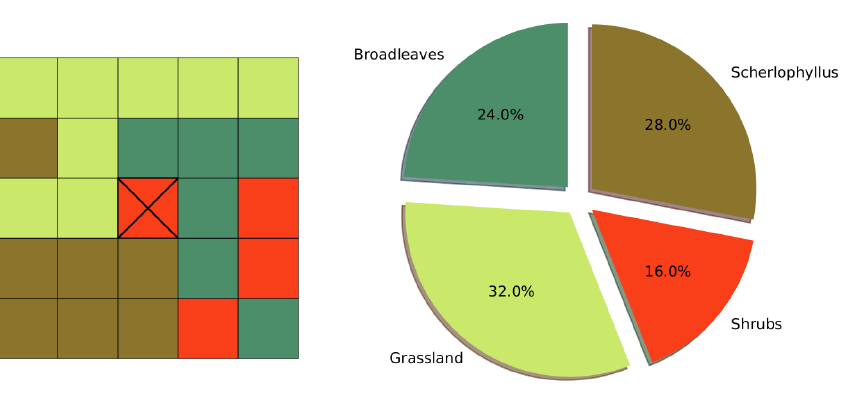
Figure 9. In this figure, a schematic representation of a Moore Neighborhood and the obtained “neighborhood percentages” of vegetation classes is shown. Of course, any other vegetation map not represented in the image is set to